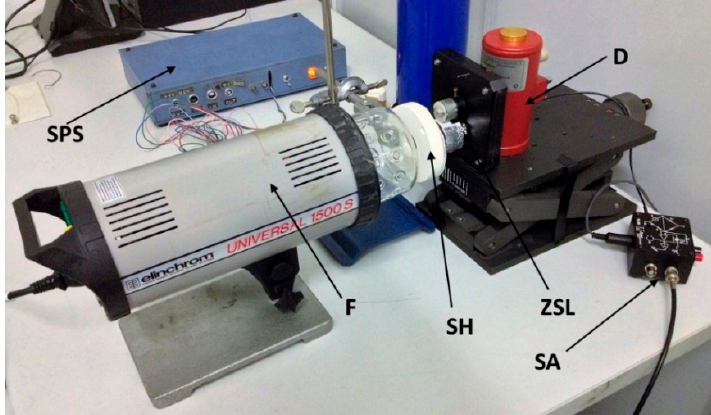
Figure 5. Experimental apparatus used for thermal diffusivity measurements: Flash ( F ), dewar ( D ), sample holder ( SH ), sensor amplifier ( SA ), sensor power supply ( SPS ), zinc selenide lenses ( ZSL ).